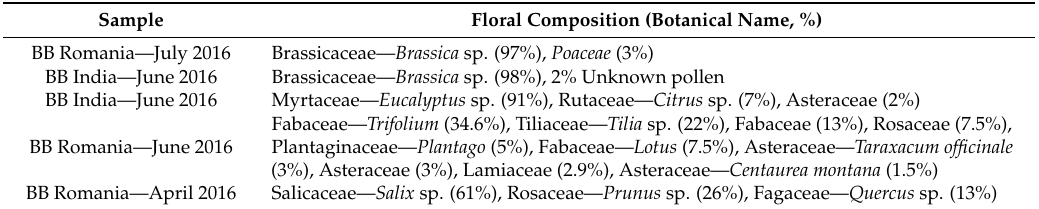
Table 1. Palynological content of bee bread (BB) samples.